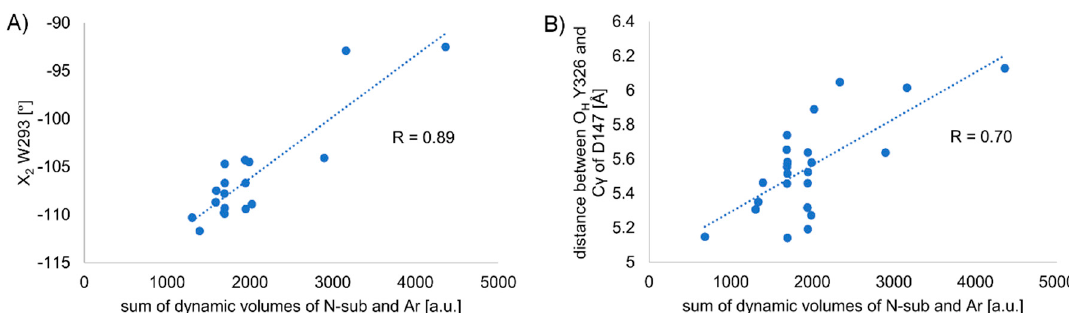
Figure 10. Correlation of volumes with receptor characteristics: A ) mean W293 X 2 dihedral measures